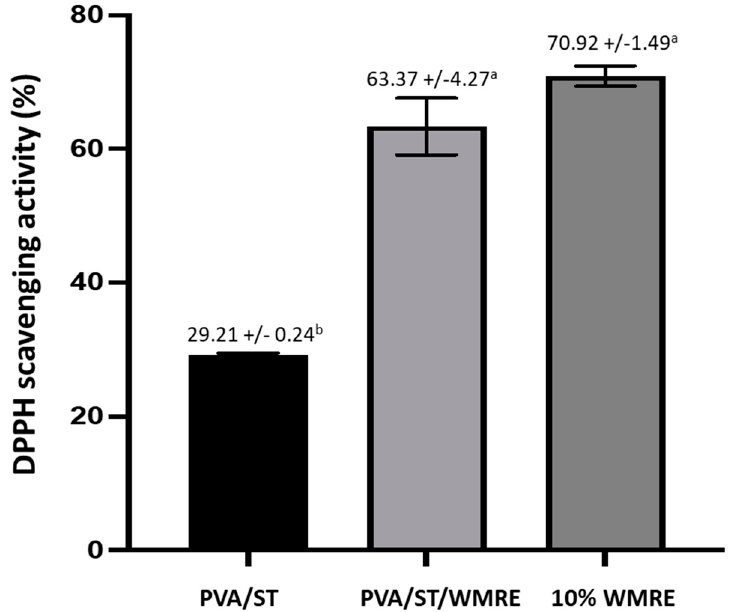
Figure 4. DPPH scavenging activity of PVA/ST, PVA/ST/WRE, and 10% v / v watermelon rind extract. The different letters represent a significant difference of p < 0.05. The error bar indicates the standard deviation (n = 3).